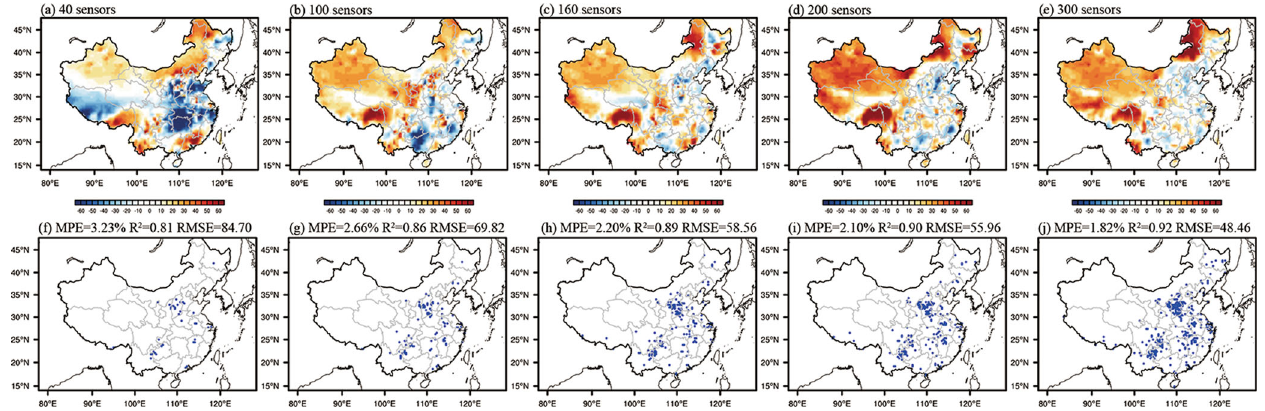
Fig. 6 Reconstruction ability of QR pivot with increasing sensor quantity. Differences between simulated and reconstructed surface CH 4 concentration using QR pivot with ( a ) 40, ( b ) 100, ( c ) 160, ( d ) 200 and ( e ) 300 sensors under the condition of P = 2 n , and associated locations of sensors ( f – j